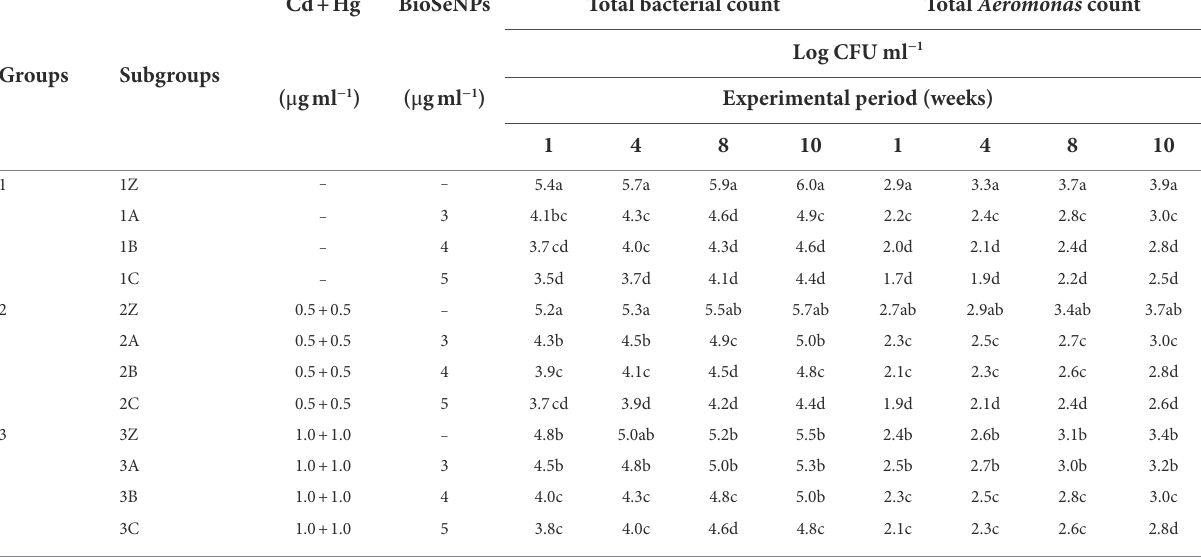
TABLE 6 Total bacterial and Aeromonas counts in fish farming water during the 10-weeks experimental period.